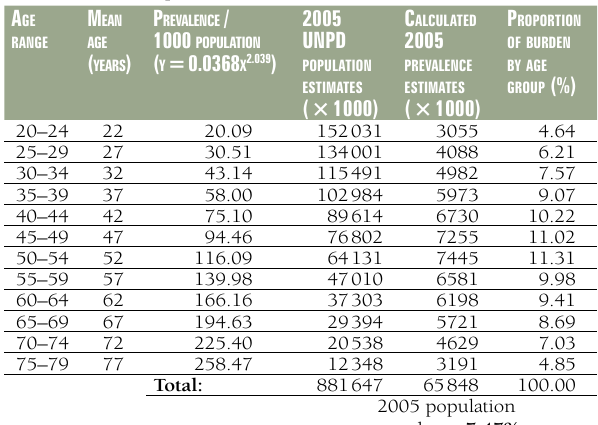
Table 12. Overall prevalence estimates for 2010